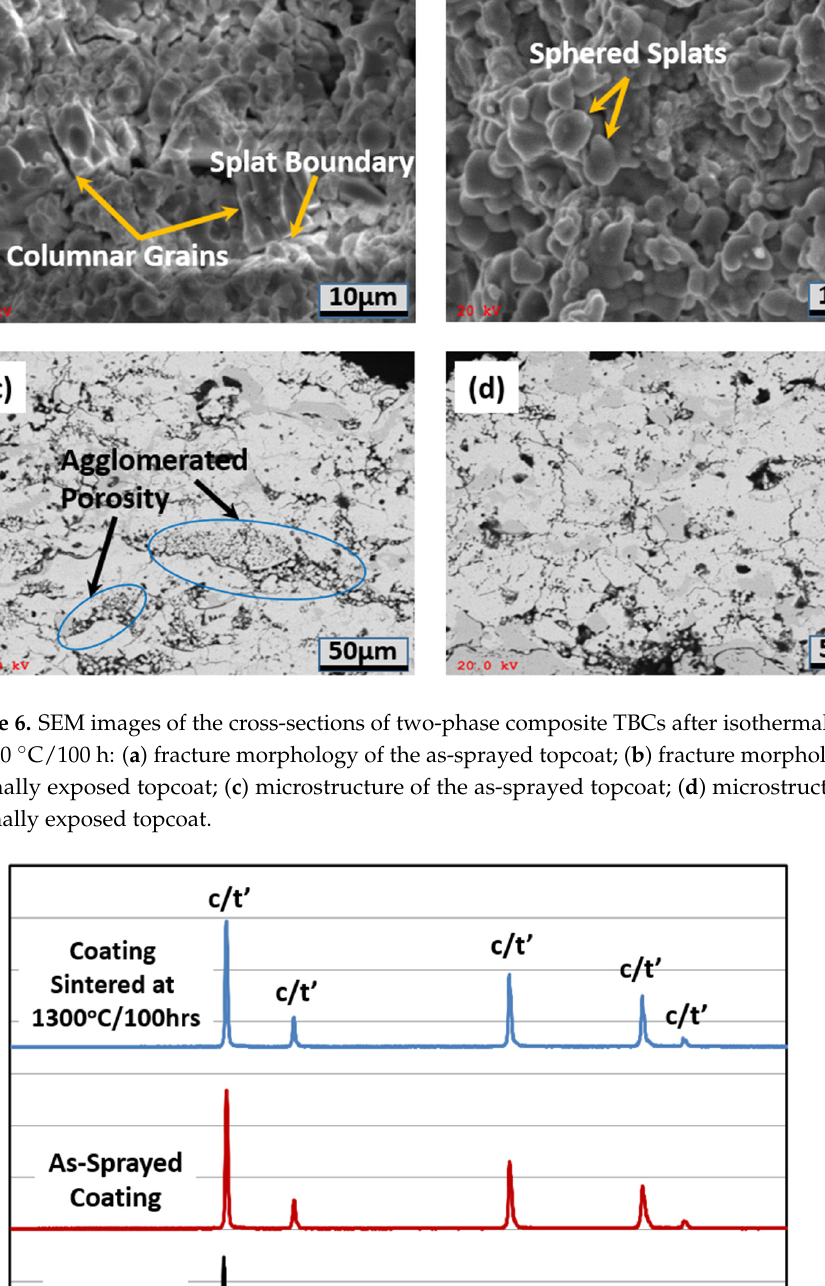
Figure 7. XRD analyses of the two-phase composite ceramic feedstock, as-sprayed topcoat, and thermally exposed topcoat.